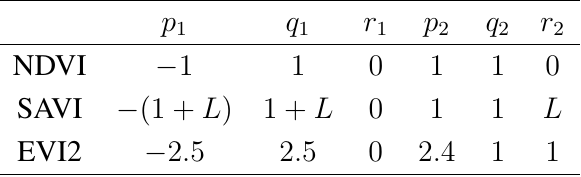
Table 1 . Coefficients of the two-band VIs ( p